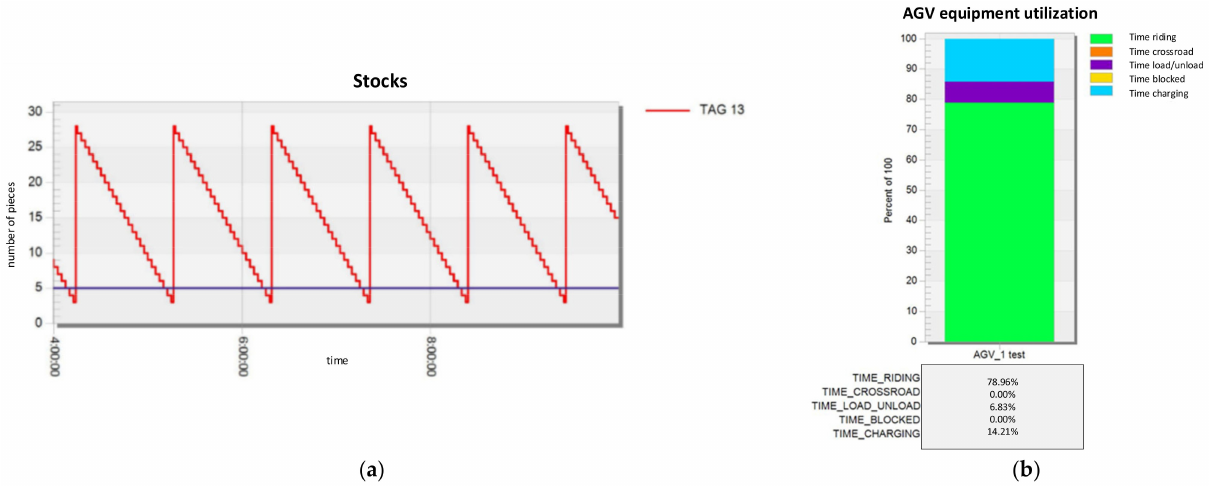
Figure 13. Illustration: ( a ) Stock status at the workplace during normal operation; ( b ) AGV use during normal operation.